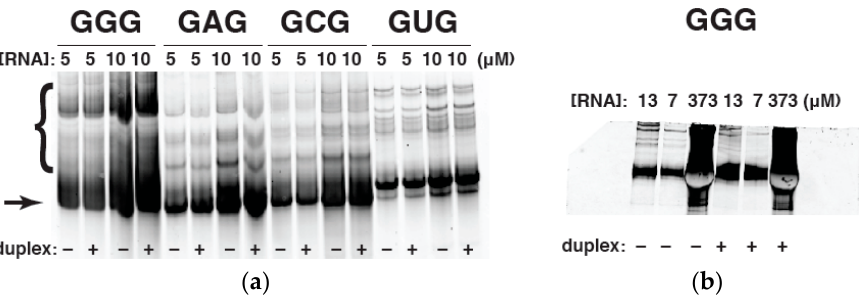
Figure 4. Native-gel electrophoresis of WXYZ RNA genotypes. ( a ) All four GMG WYXZ RNA genotypes run at either 5 μ M or 10 μ M concentrations, with or without the complementary duplex RNA present. The upper bands, indicated by bracket, denote excessive multi-RNA complex formation by the GGG genotype. The lower band, indicated by arrow, denotes the dominant (non-aggregated) RNA species; ( b ) The GGG WXYZ genotype run in a range of concentrations ranging from 7–373 μ M; the gel loading order was chosen to juxtapose maximum and minimum concentrations. The presence of the duplex RNA does not appear to affect aggregation, but the RNA concentration does. All concentrations are given in units of micromolar.